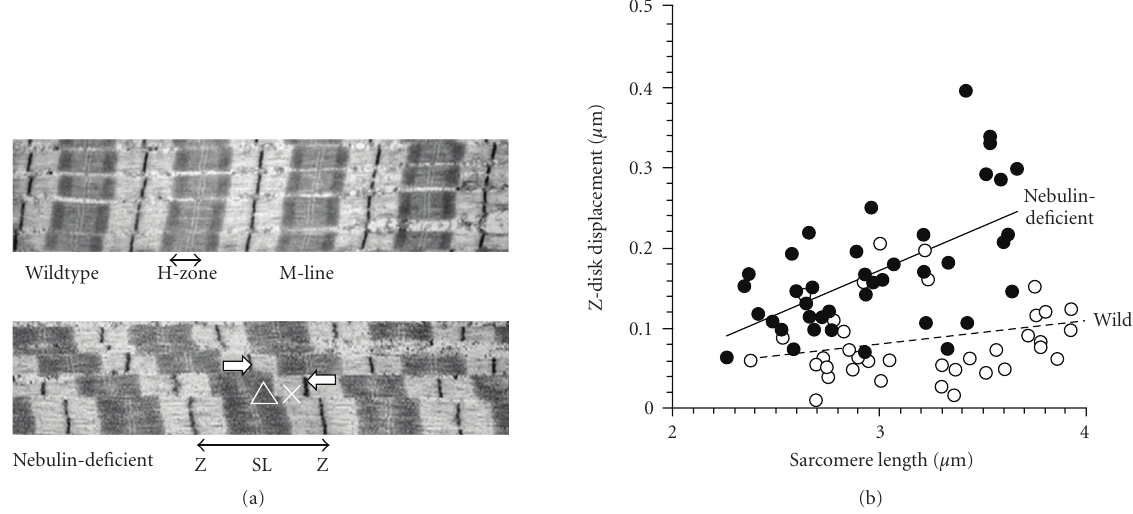
Figure 3: (a) Wildtype fibers have a regular structure with well-aligned sarcomeres. In nebulin-deficient fibers sarcomeres are misaligned and the Z-disk are out of register. Arrows indicate how Z-disk displacement ( Δ X) was defined. (b) Z-disk displacement is significantly increased in nebulin-deficient fibers. (modified from Tonino et al.